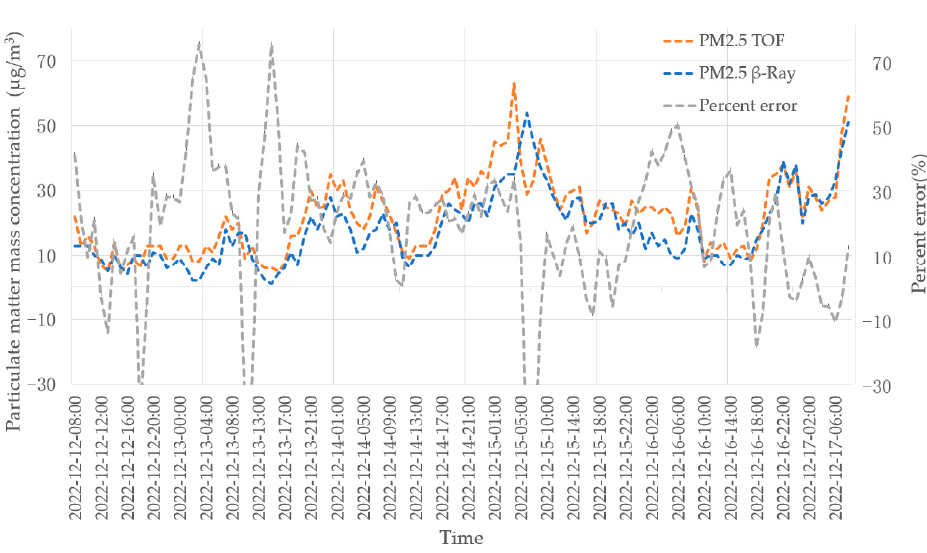
Figure 12. Actual measured concentration of PM2.5.